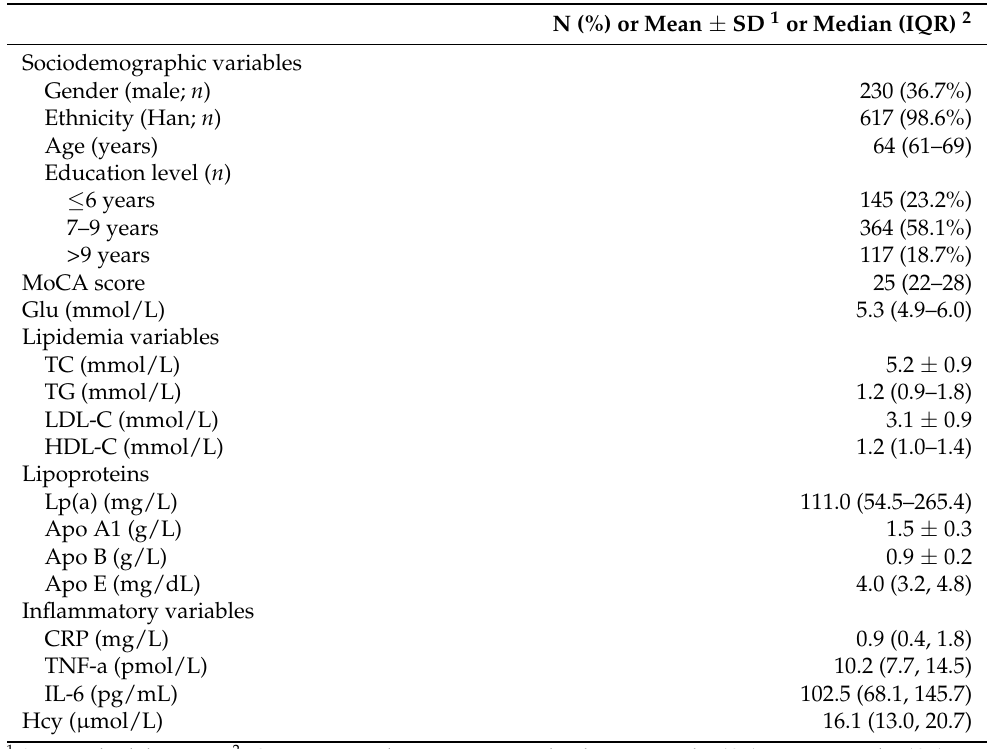
Table 1. General characteristics of study participants ( n =